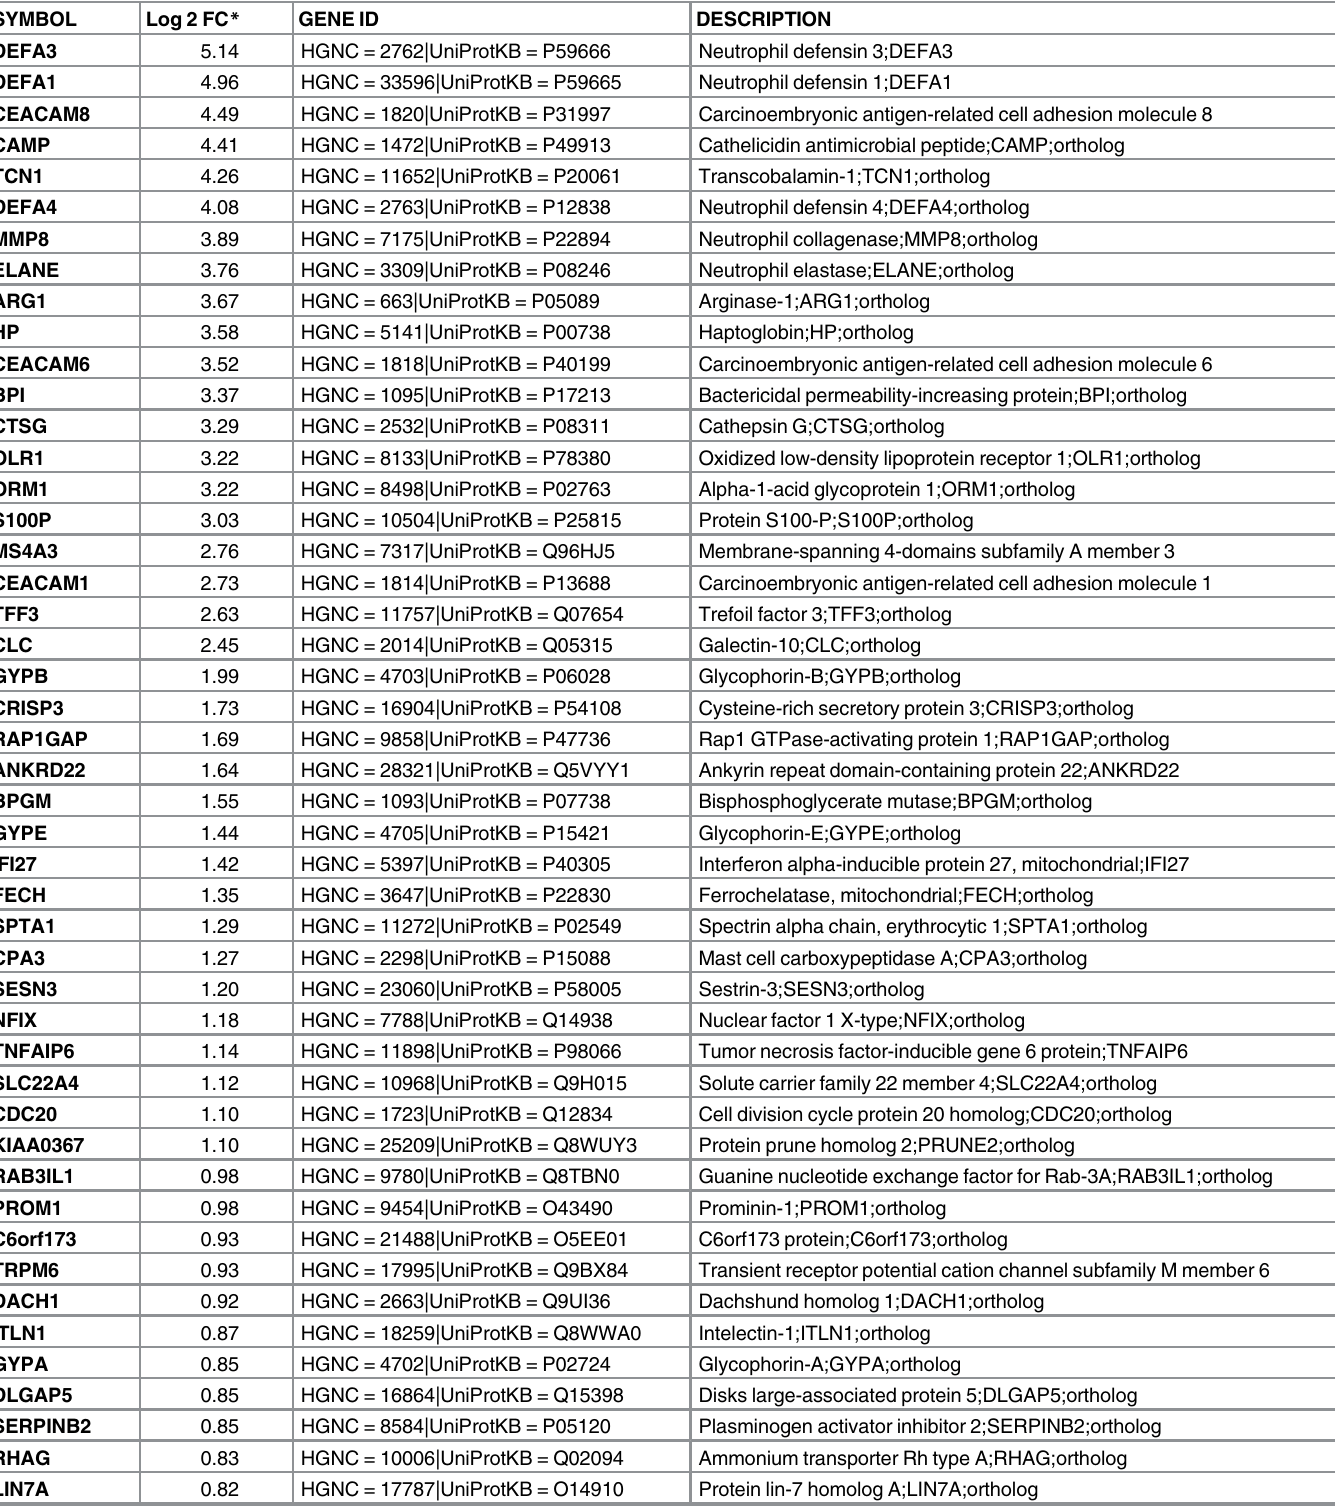
Table 4. Unique DOX-induced DEG in patients with abnormal decline of LVEF after one dose of DOX-based chemotherapy (p < 0.05, FDR < 0.1).